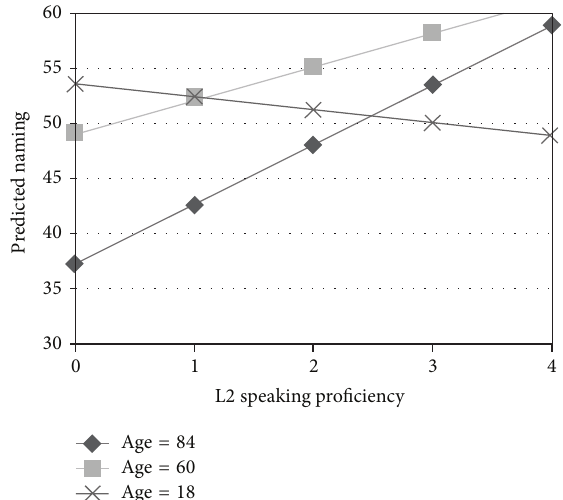
Figure 2: Estimated effect of L2 speaking proficiency on naming (mean values for education, L2 reading, and writing proficiencies).